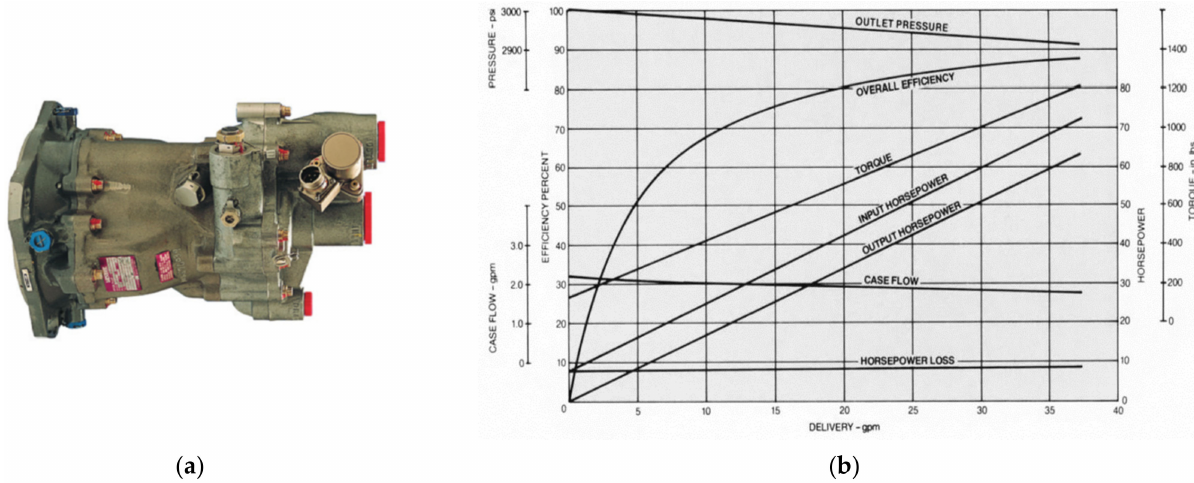
Figure 2. Engine driven pump of the Airbus A320 (from Eaton flyer): ( a ) A320 engine-driven pump; ( b ) typical steady-state power